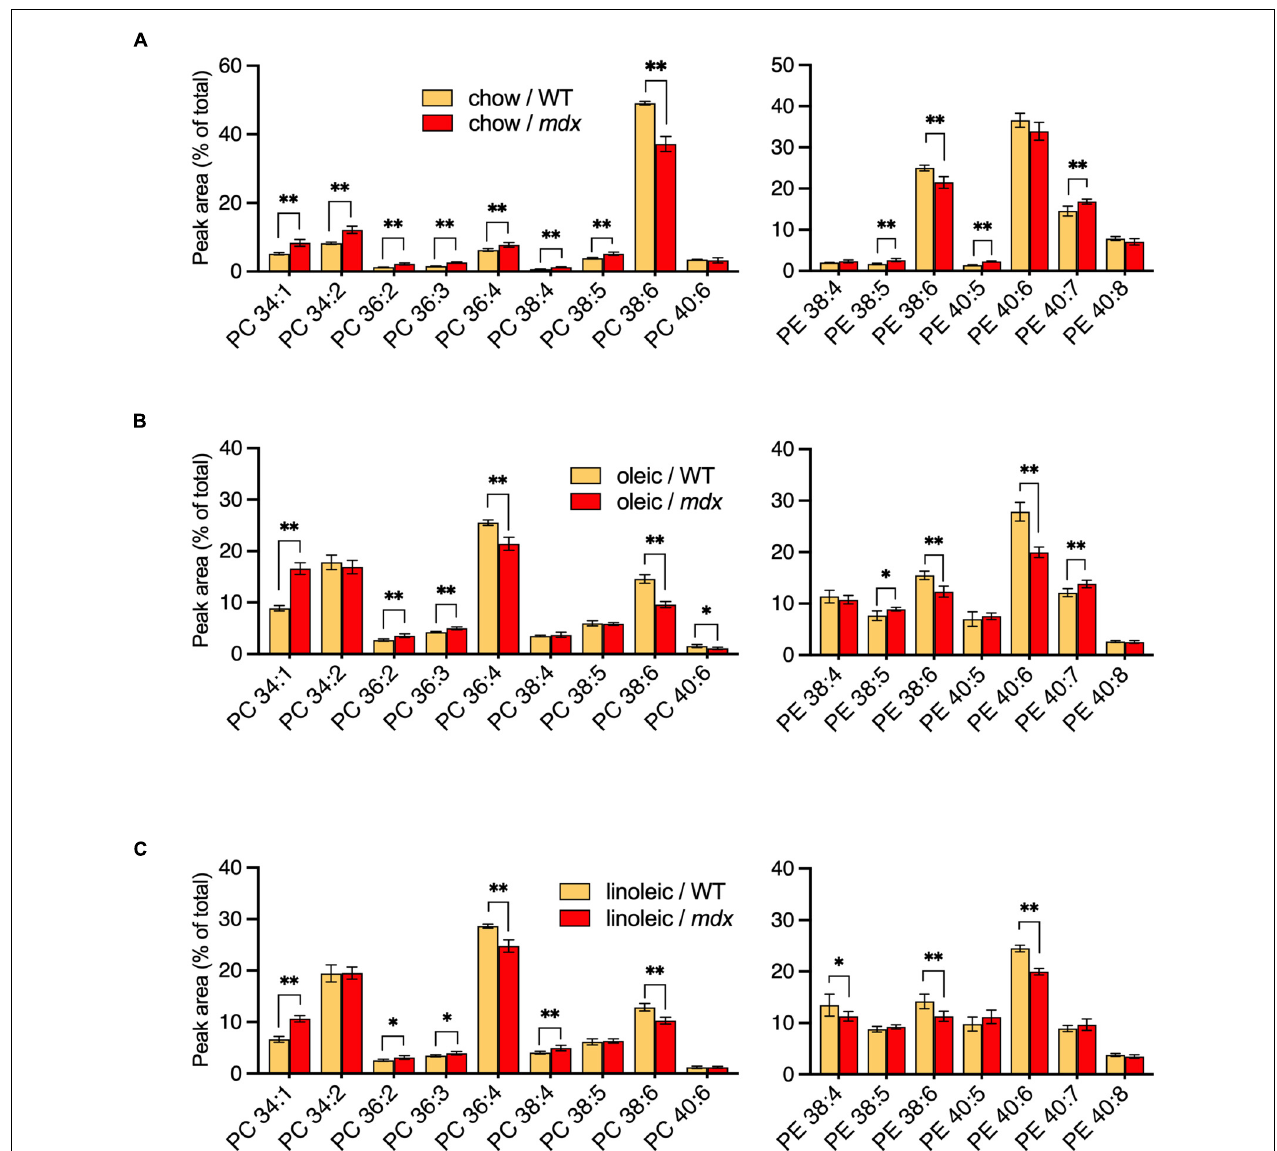
FIGURE 6 | PC and PE profiles of EDL from 12-week-old B10-WT and - mdx mice fed different diets from birth. Mice were raised on CE-2 standard chow (chow) (A) , or custom diets rich in FA 18:1 (oleic) (B) or FA 18:2 (linoleic) (C) . PC compositions were measured by LC-MS. PC 34:1 showed a similar increase in mdx tissue regardless of diet, but increased PC 34:2 was variably detected in mdx tissues, depending on the diets. PC and PE peak values are expressed as the percentage of total signals and means ± SD are plotted. Significance is based on FDR-controlled multiple t -tests (FDR < 5%). ∗ p < 0.05, ∗∗ p < 0.01; n = 4–8